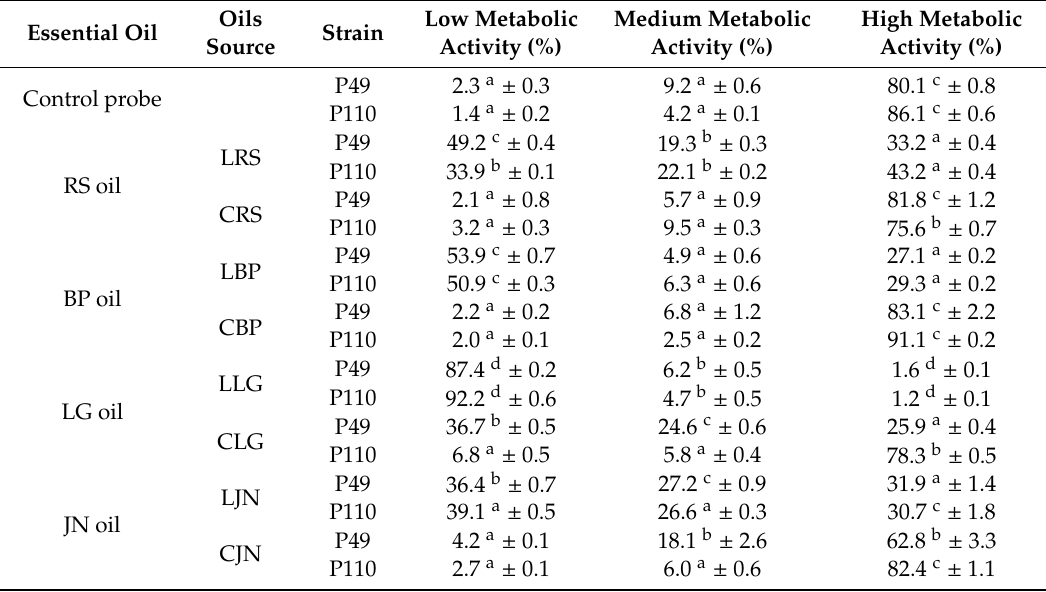
Table 4. The comparison of percentage of cells incubated in the presence of commercial oils and of oils produced in our laboratory in fractions with low, medium (viable but nonculturable cells) and high metabolic